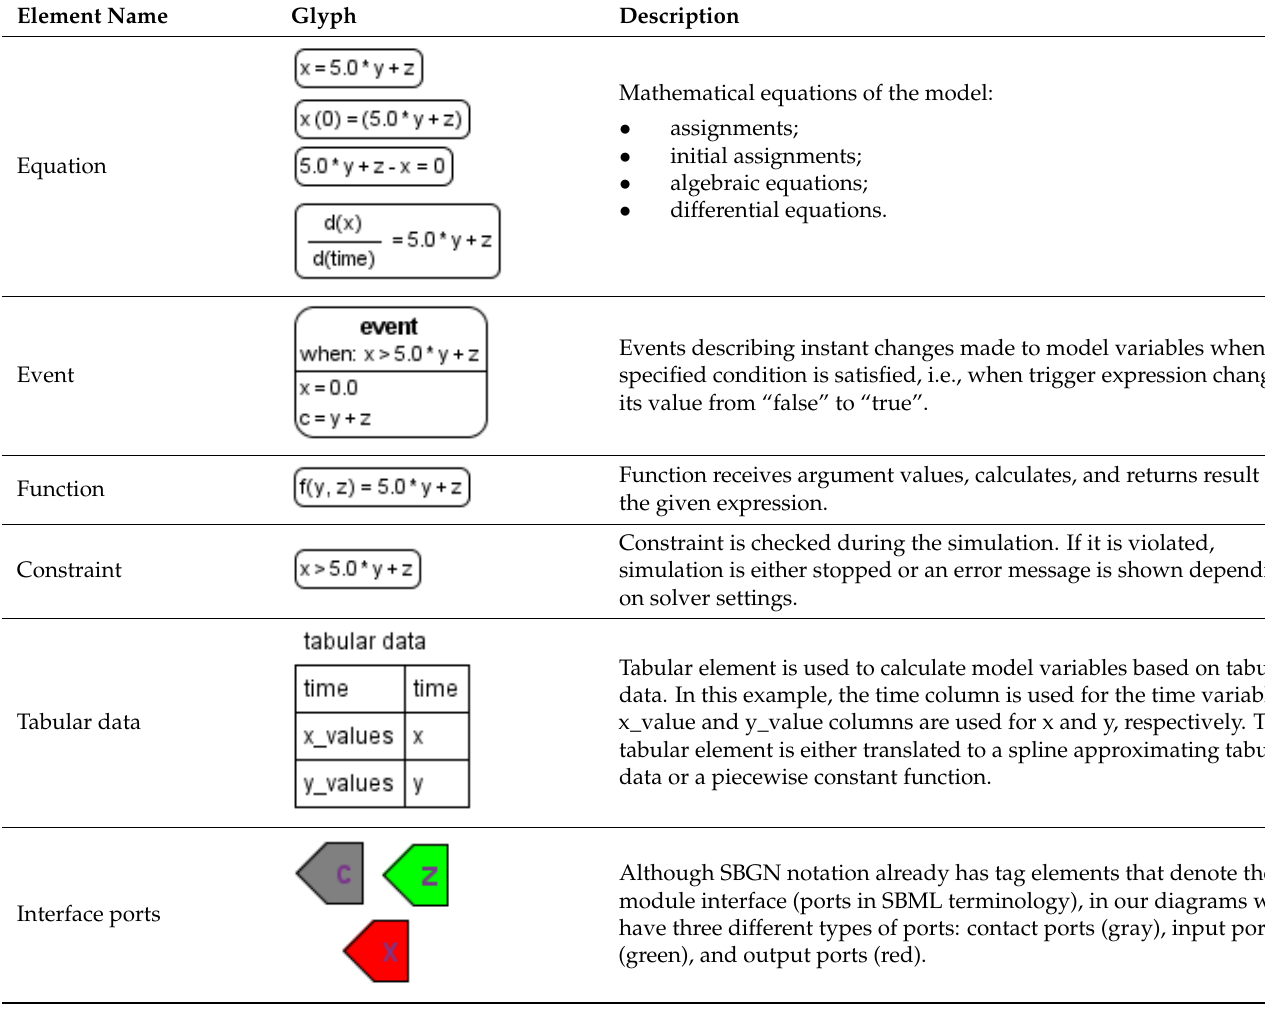
Table 1. Glyphs for new entities for the SBGN Process Diagram.